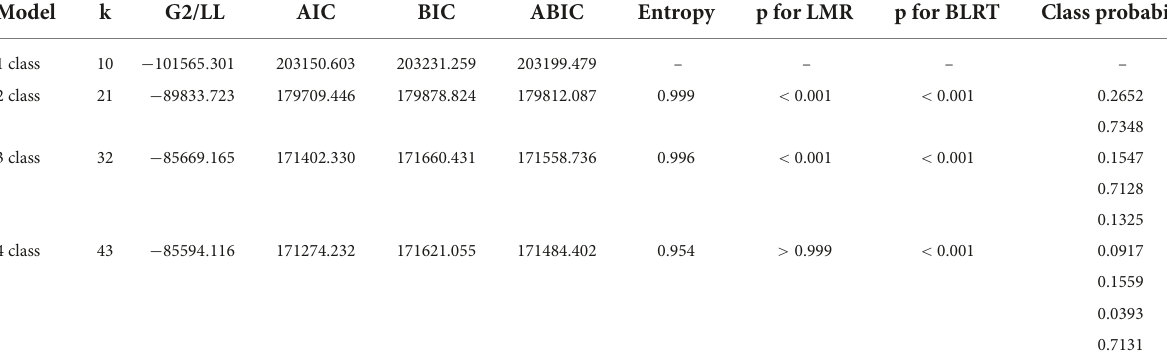
TABLE 4 Summary of fitting information for latent class analysis.